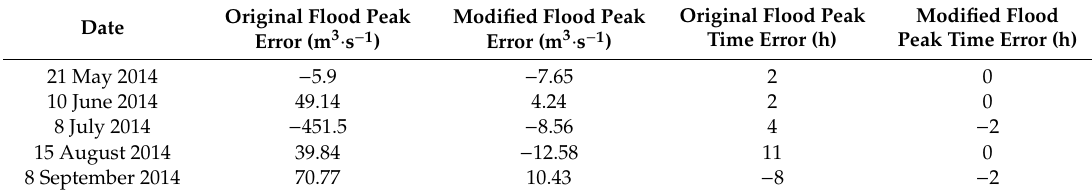
Table 5. Simulation results of flood peak before and after model modification during the validation